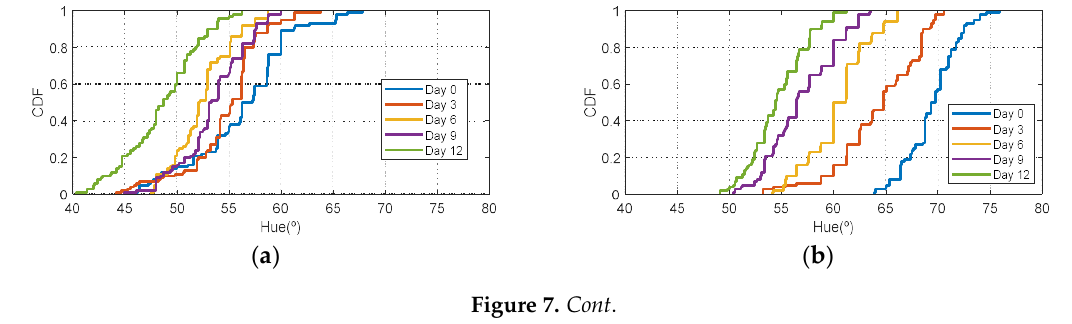
( d ) Figure 7. Cumulative Distribution Function (CDF) of the hue parameter for the golden apple in the fridge ( a ) and at room temperature ( b ) as a function of the number of days out of the fridge. Cumulative Distribution Function (CDF) of the saturation parameter for the golden apple in the fridge ( c ) and at room temperature ( d ) as a function of the number of days out of the fridge.